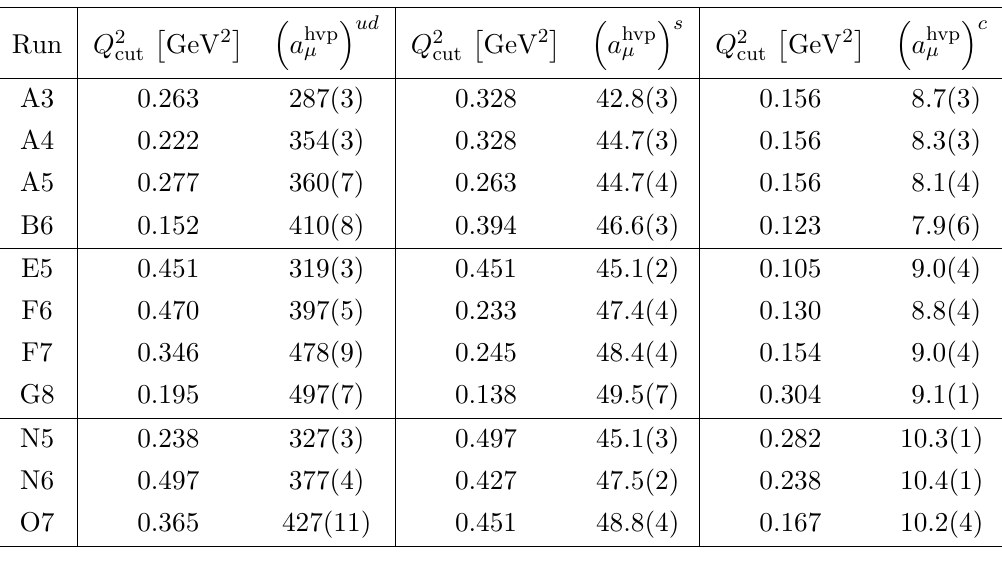
Table 4 . Results for the various (cid:13)avour contributions to a hvp the hybrid method. For Q 2 < Q 2 time